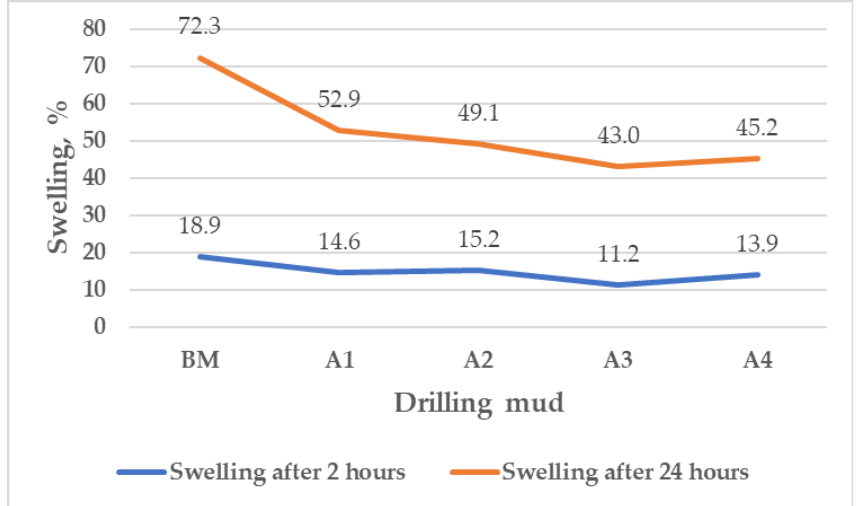
Figure 7. Pellet swelling in base mud and in mud with added MPP (particles less than 0.1 mm) within 2 and 24 h at room temperature.